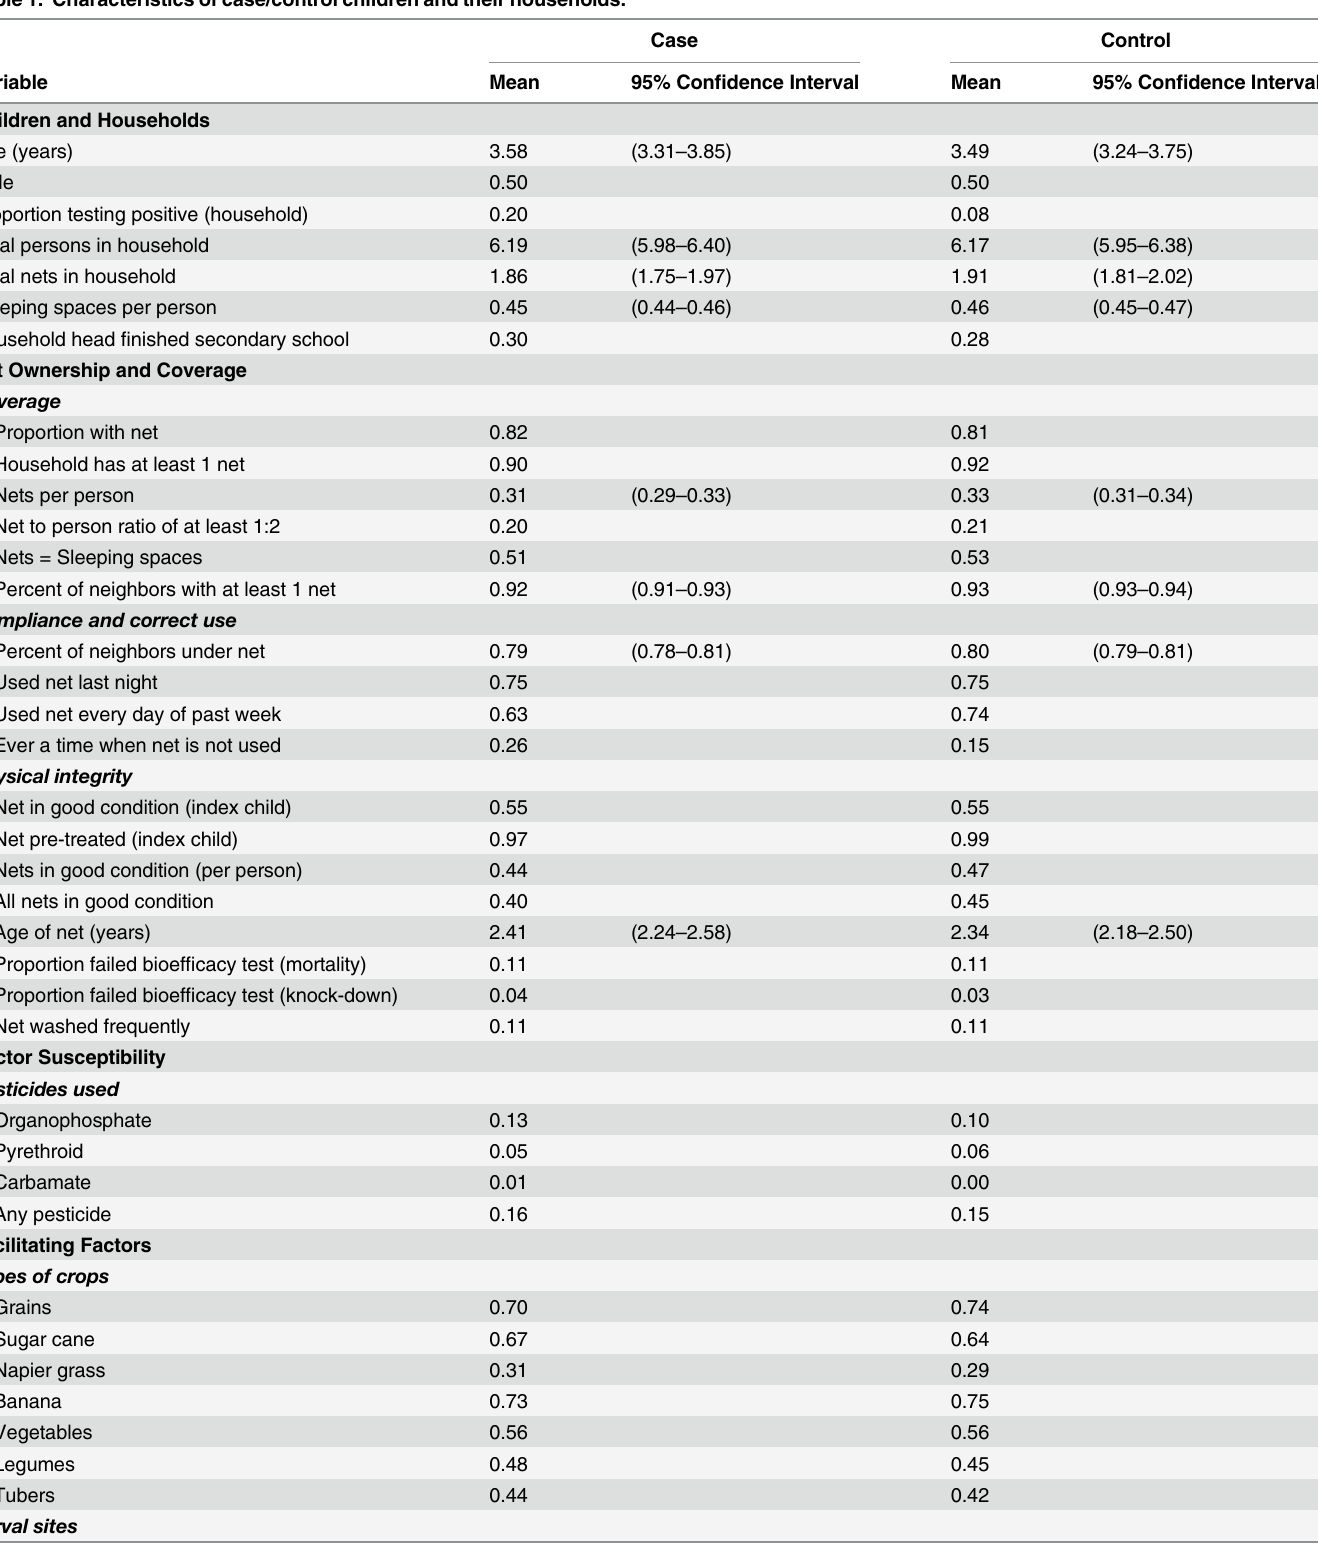
Table 1. Characteristics of case/control children and their